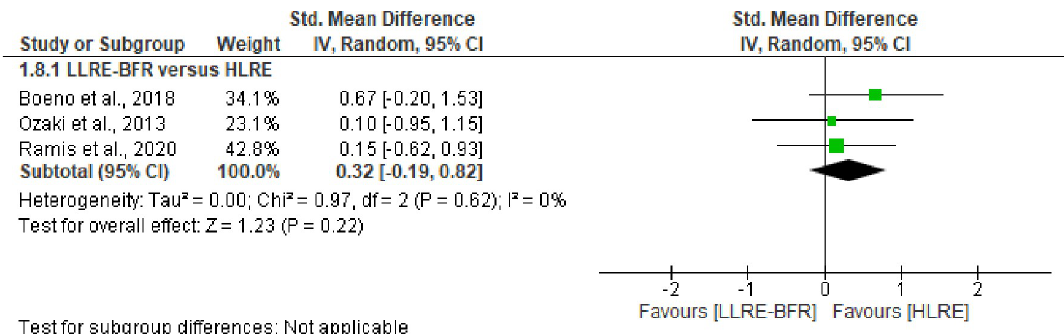
Fig 5. Forest plot about effects of LLRE-BFR versus HLRE on biomarkers of production of NO post-exercise. LLRE-BFR: Low load resistance exercise with blood flow restriction; HLRE: High-load resistance exercise, LLRE: Low load resistance exercise; SMD: Standardized mean difference; SD: Standard deviation; IV: Inverse variance; CI: Confidence interval.